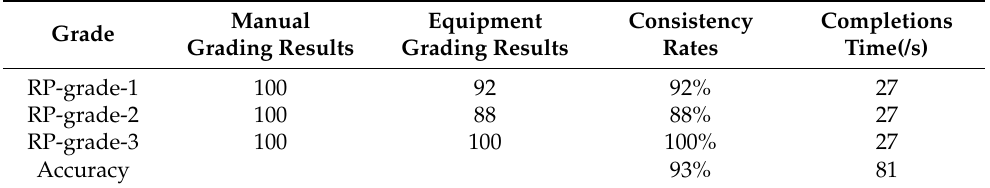
Table 4. Grading experimental data.